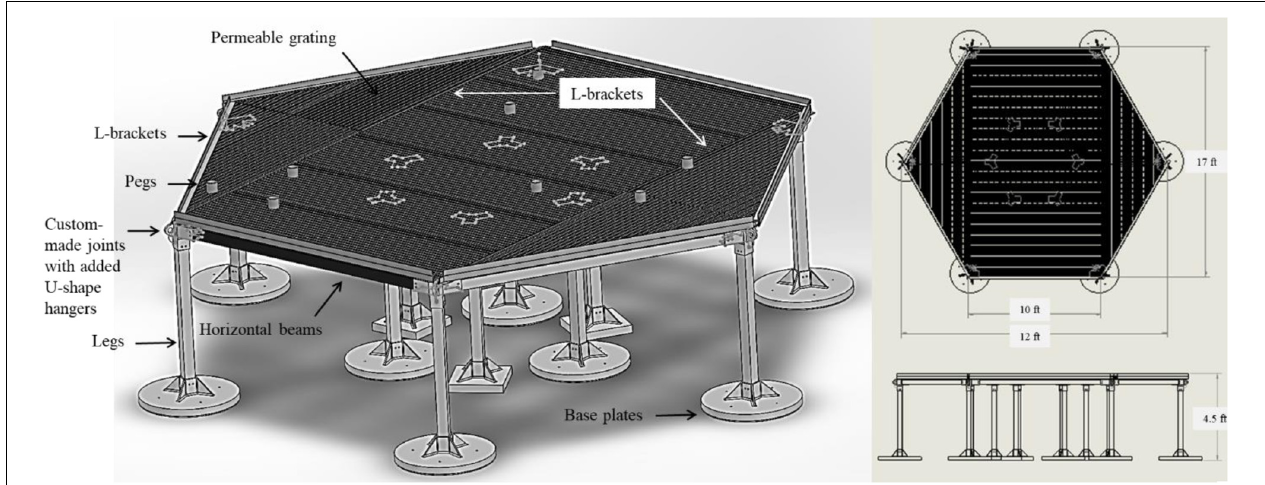
FIGURE 1 | Computer-Generated design of the coral nursery structure, with overall dimensions on the